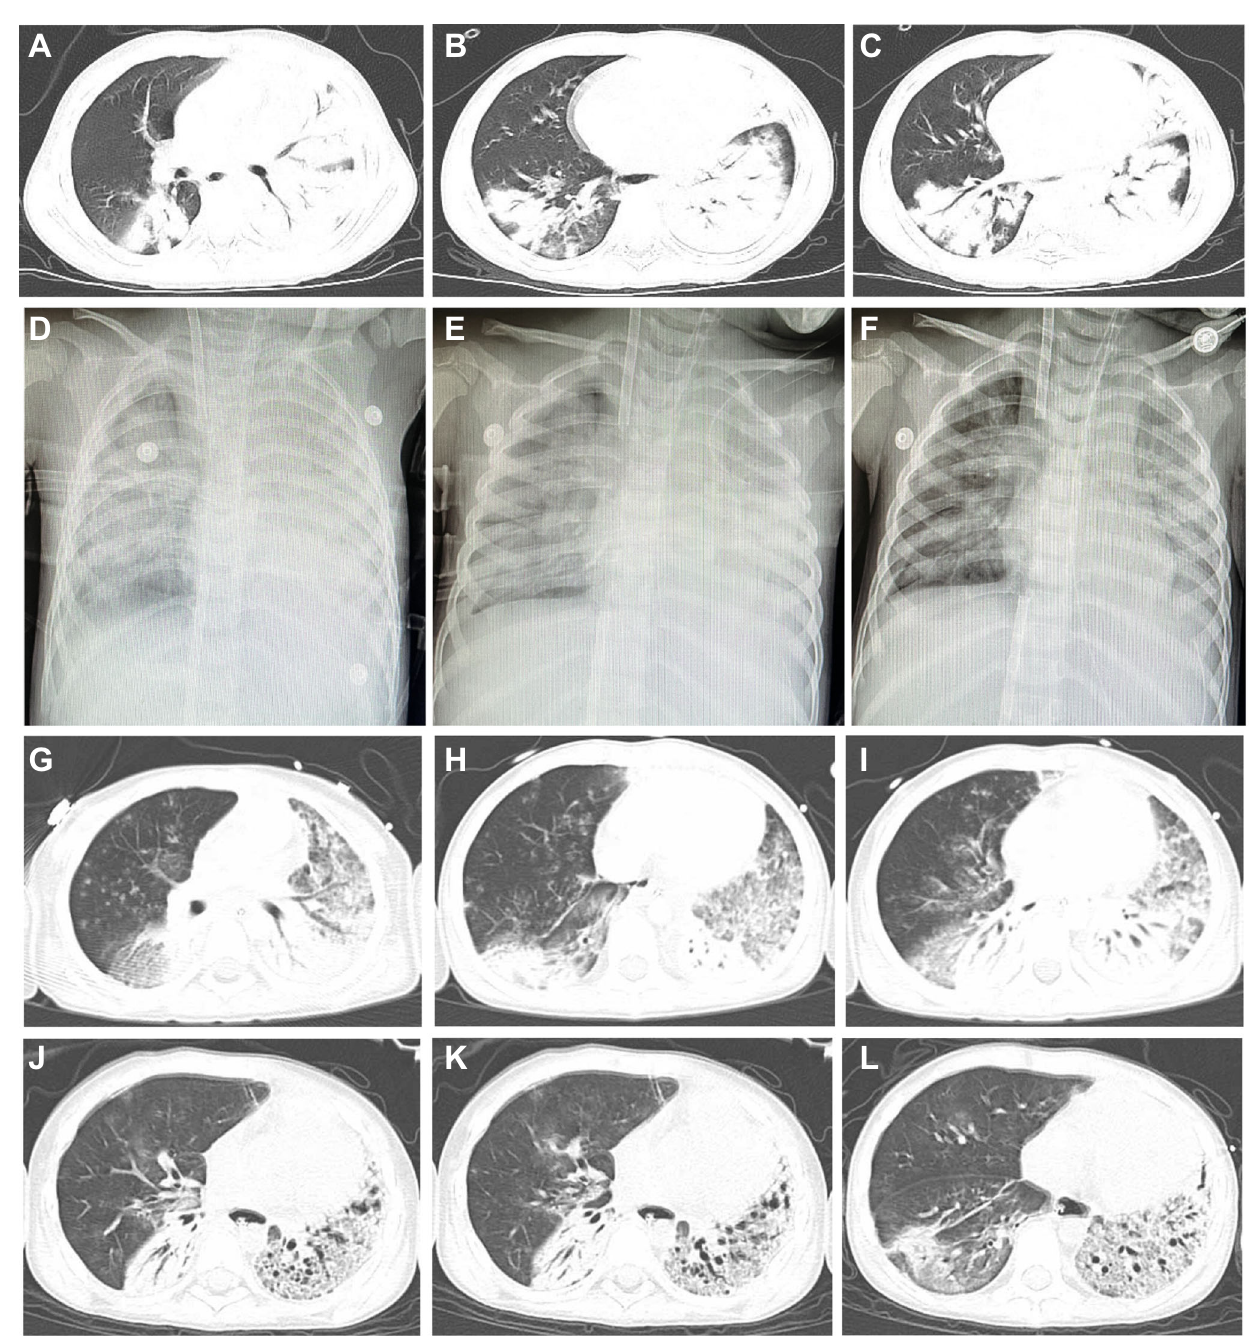
Fig.2|Imagingofthepatient ’ schest. Computedtomographic(CT)scanobtained on day 6 of illness ( A – C ).CTscanshowed multiple patchyhigh-density shadows in both lungs, especially in the lower lobe of the right lung and the left lung. Chest radiographs showed patchy high-density shadows in both lungs on day 7 of